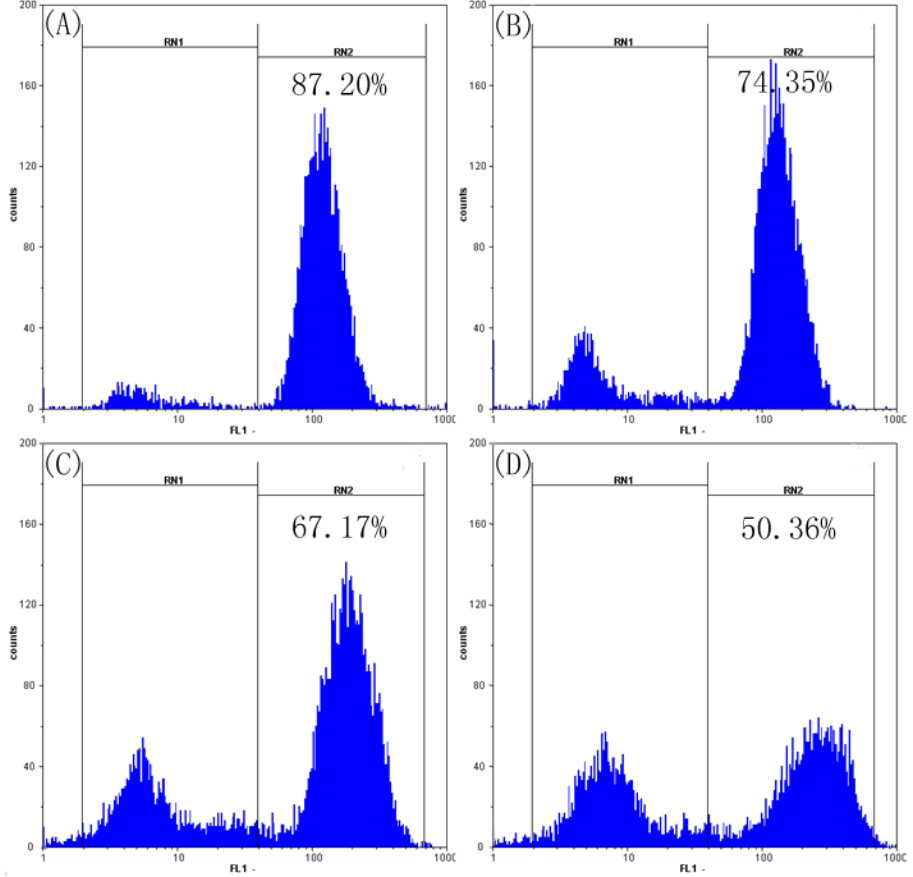
Figure 5. Effects of SFE-CO extract on MMP of SMMC-7721 cells assayed by flow 2 cytometry analysis of Rh 123 stained cells. ( A ) Untreated control cells; ( B )-( D ) treatment with 50, 100 and 200 μ g/mL SFE-CO 2